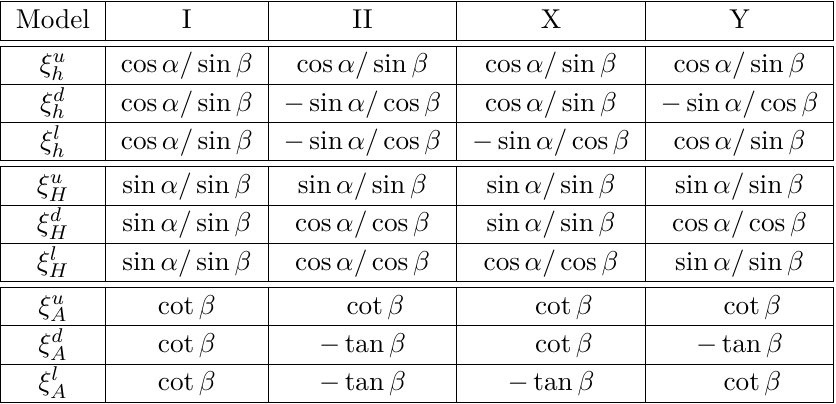
Table 2 . Coupling strengths ξ in each type of 2HDM between the Higgs particles and fermions. where the factor η for fermion type f = d, ‘ is 1 and for f = u is − 1 . Imposing the f fermion interactions to specific doublets in table 1, the ξ coupling strengths are expressed in table 2.